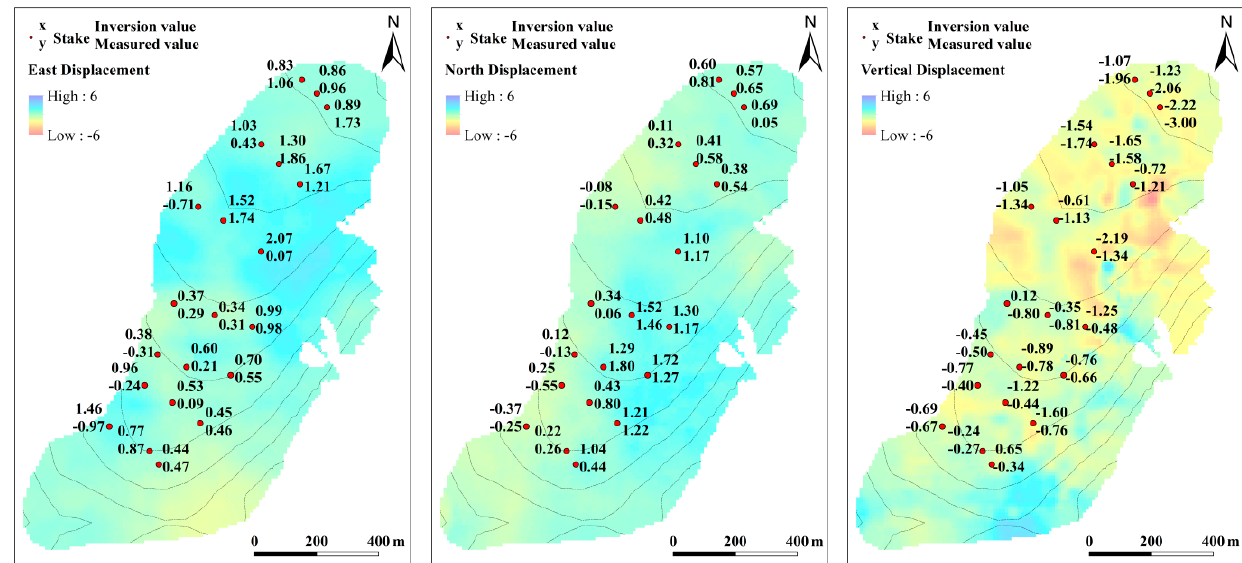
Figure 4. Displacement distribution of the east branch of No.1 Glacier in three directions (unit: m).